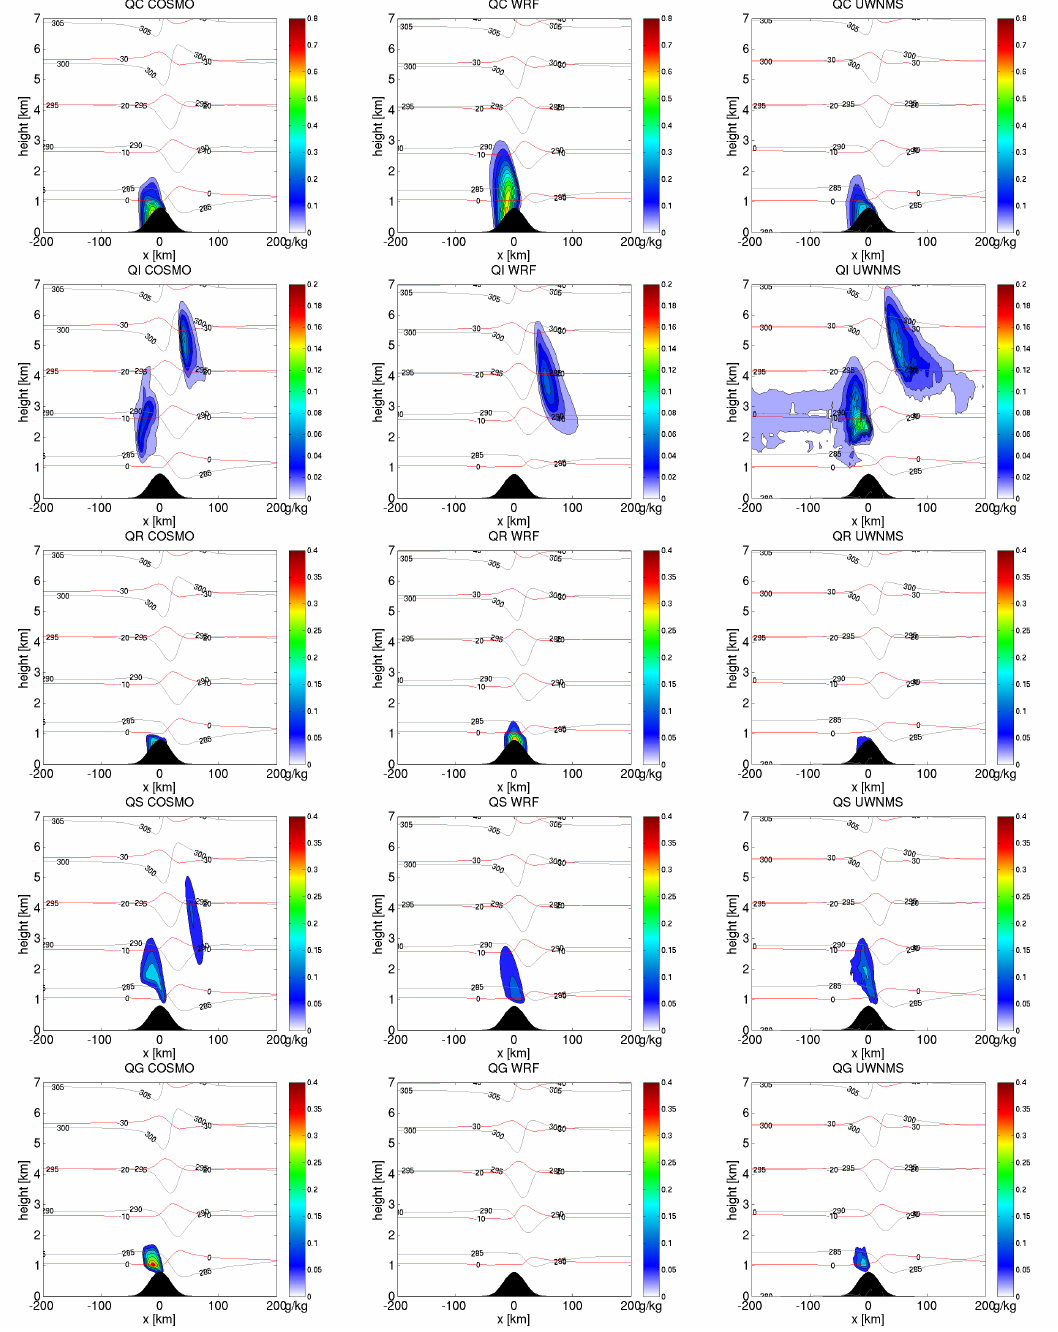
Fig. 5. Same as Fig. 4 but for the mass mixing ratios (units gkg − 1 ) of cloud water (QC), ice (QI), rain (QR), snow (QS) and graupel